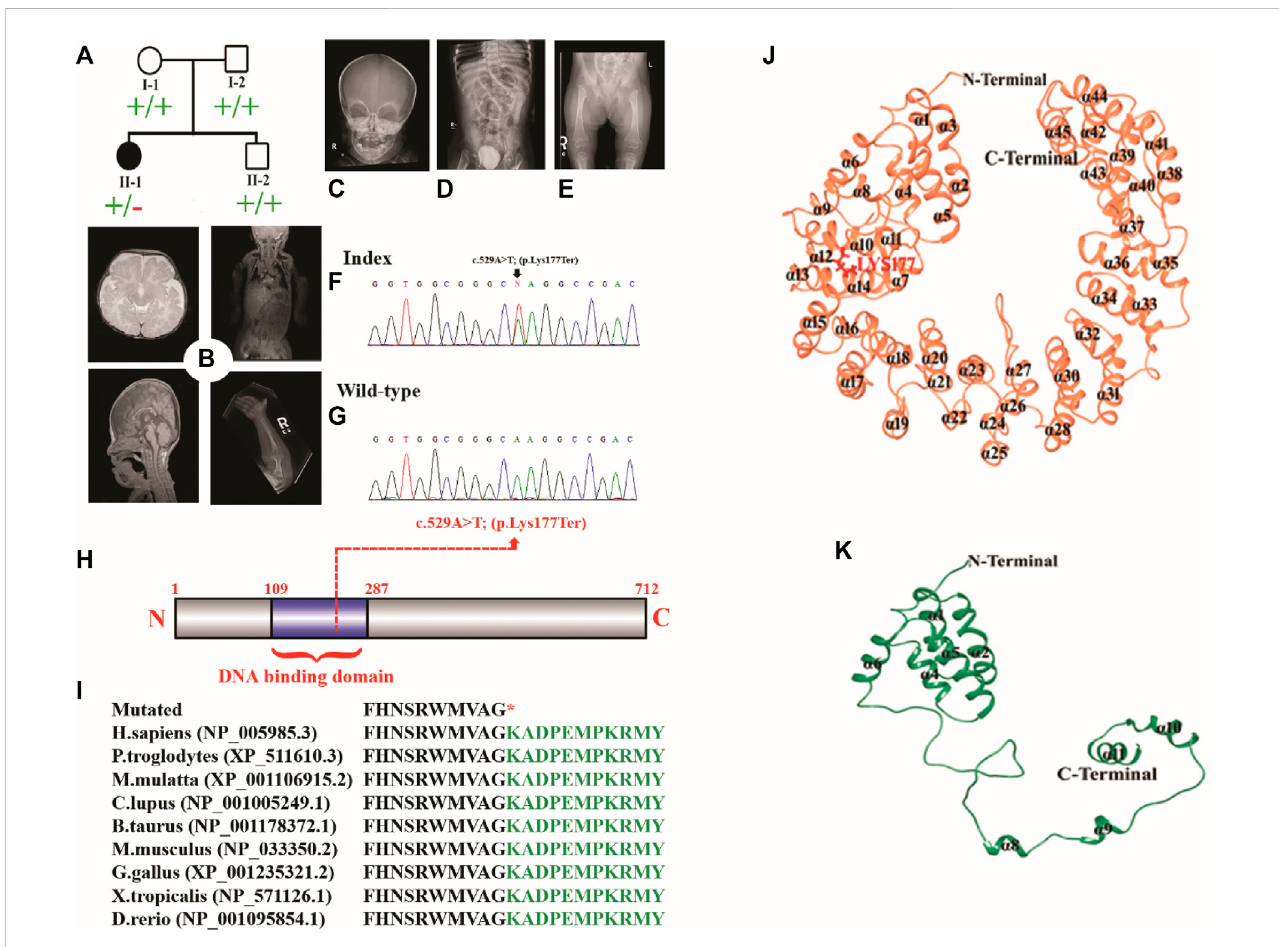
FIGURE 1 (A) Pedigree of the investigated family. (B – E) MRI and radiographs of the proband showing platybasia at the skull base, delayed myelination for the patient ’ sage,andsevereskeletaldeformities. (F,G) Sangersequencingelectrogramsoftheprobandandwild-type. (H) SchematicdiagramoftheTBX2protein showing the position of the identi fi ed variant. (I) Partial amino acid sequence of the TBX2 protein showing conservation of Lys177 across different species. (J, K) Mutational and structural analyses of TBX2. Structural differences between (J) TBX2 WT (coral) and (K) TBX2 LYS177TER (sea green). All the secondary structures, N-terminal, and C-terminal are labeled in black color. Lys177 is shown and labeled in red